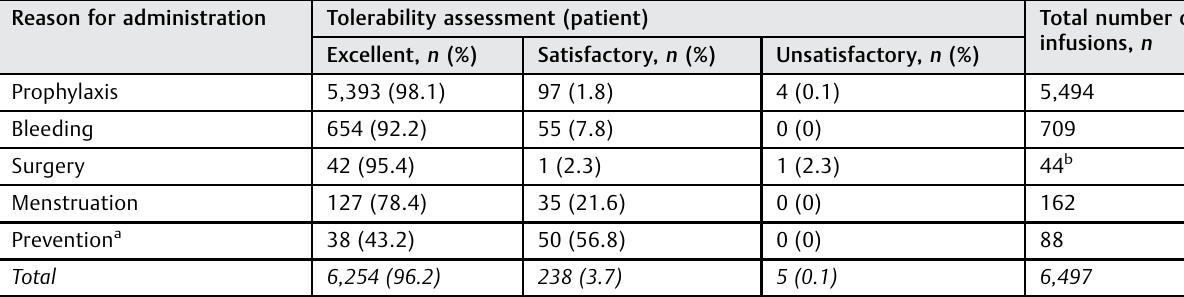
Table 2 Tolerability assessment of wilate infusions by reason for